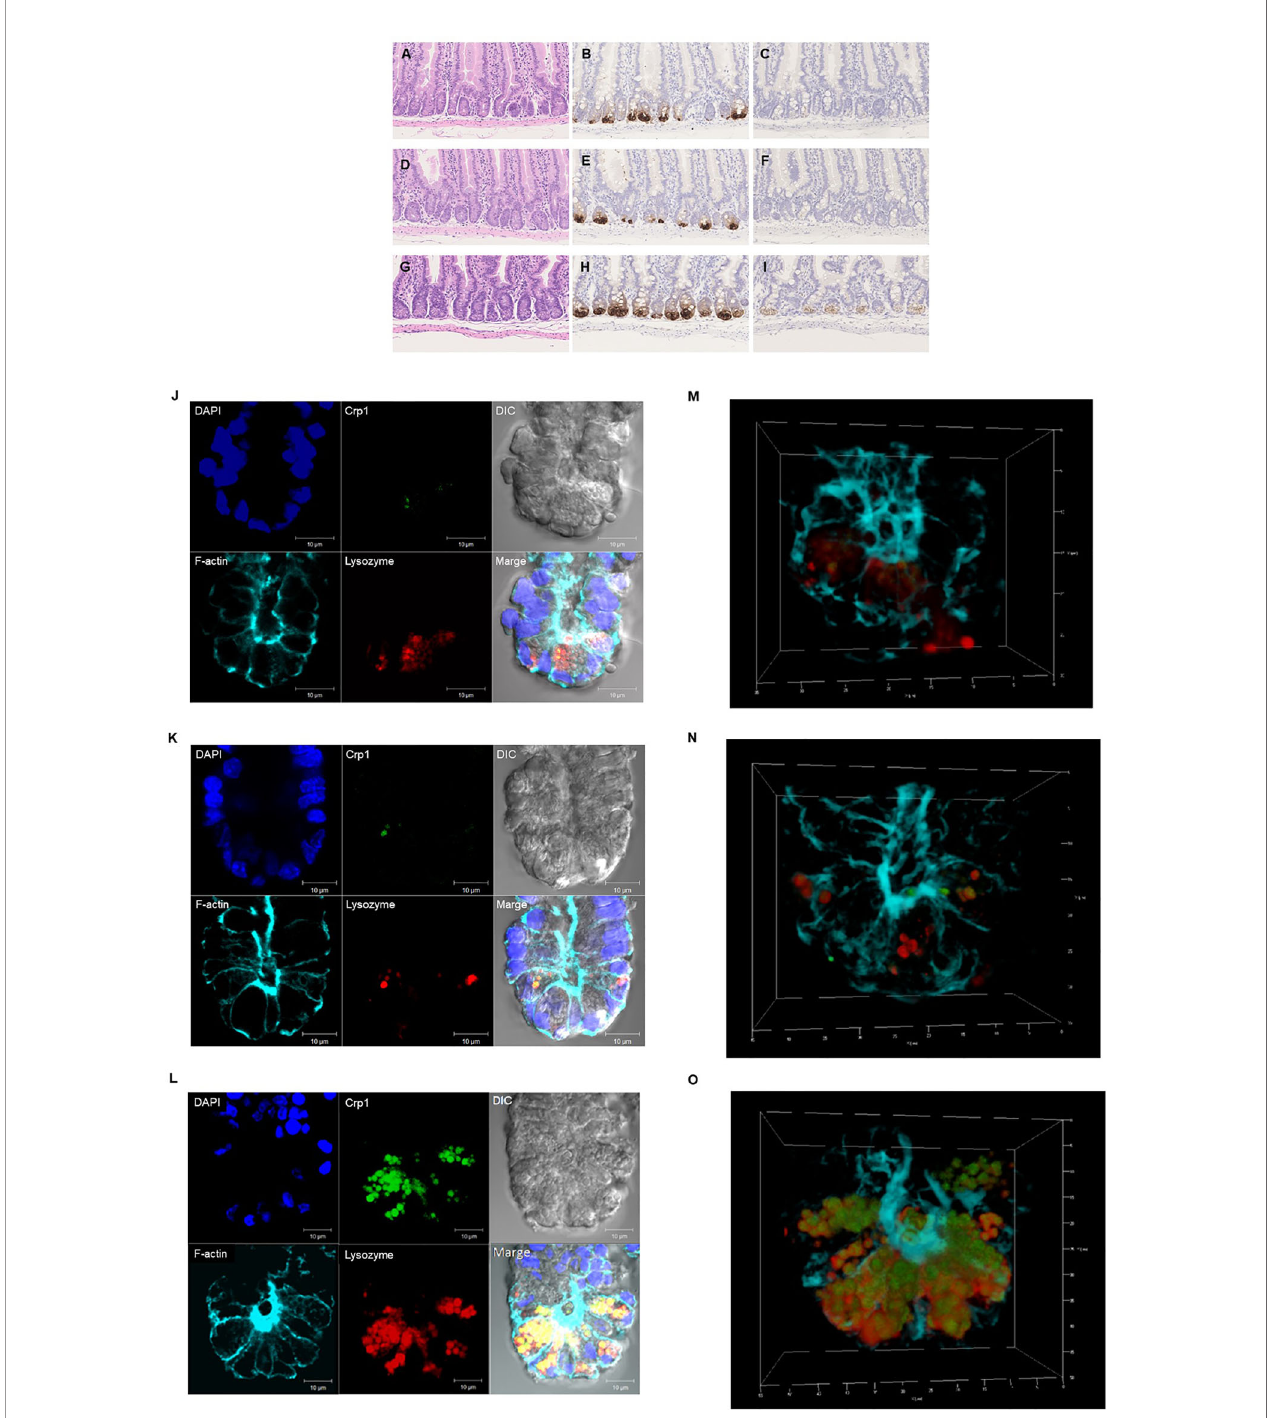
FIGURE 2 | Histological and immunohistochemical analyses of the small intestine. Hematoxylin-eosin staining of the duodenum (A) , jejunum (D) , and ileum (G) . and immunohistochemical analysis of Crp1 in the duodenum (B) , the jejunum (E) , and the ileum (H) and Crp4 in the duodenum (C) , the jejunum (F) , and the ileum (I) of mouse small intestine. Immunohistochemical analyses of isolated single crypt from duodenum (J) , jejunum (K) , and ileum (L) using confocal microscopy. Representative images of each site with Crp1 and lysozyme staining together with 4 ’ ,6-diamidino-2-phenylindole (DAPI), F-actin, and differential interference contrast (DIC) were shown. The same crypt observed in (J – L) with Crp1, lysozyme, and F-actin were shown by 3D images in (M – O) , respectively. A representative image of 10 crypts was